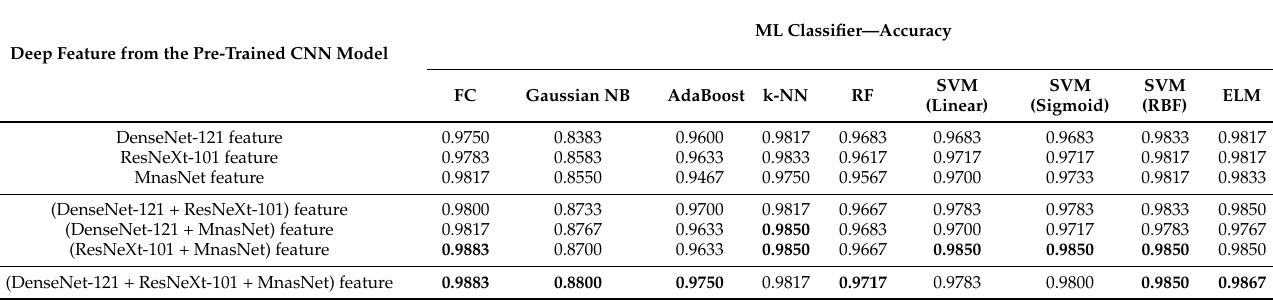
Deep Feature from the Pre-Trained CNN Model